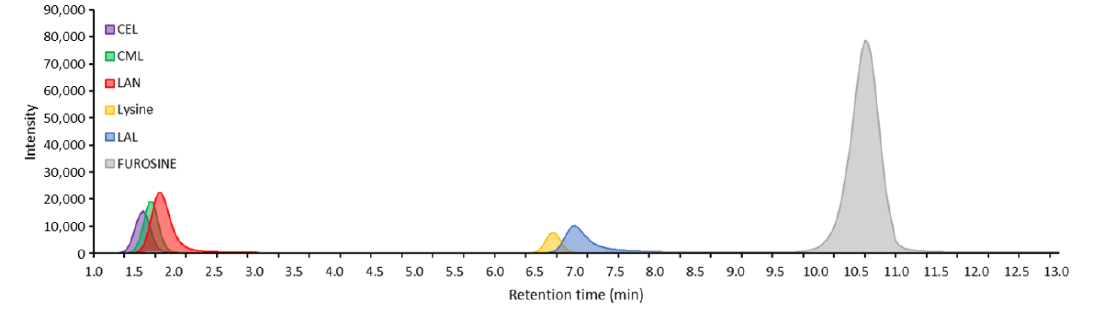
Figure 2. Total ion chromatograms of standard solutions of N ε -(1-Carboxyethyl)-L-lysine (CEL; 62.5 ng/mL), N ε -(1-Carboxymethyl)-L-lysine (CML; 62.5 ng/mL), lanthionine (LAN; 250 ng/mL), lysinoalanine (LAL; 750 ng/mL), lysine (62.5 ng/mL) and furosine (62.5 ng/mL) using LC-MS triple quadrupole in MRM acquisition mode. Table 4. Validation parameters (R 2 values, LOD, LOQ, precision and recovery) for each individual compound included in the LC-MS method .